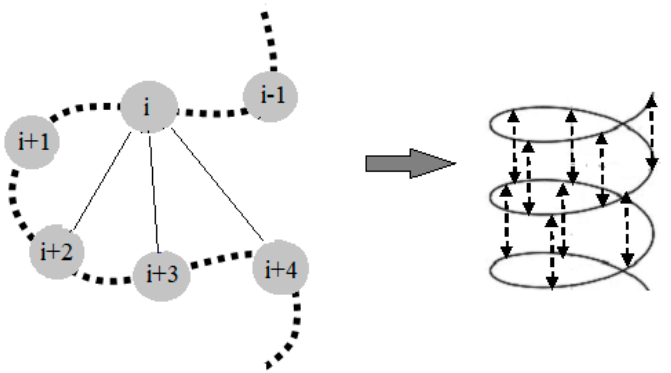
Figure 3. Regular NOE patterns for secondary stricture determination of α -helix.